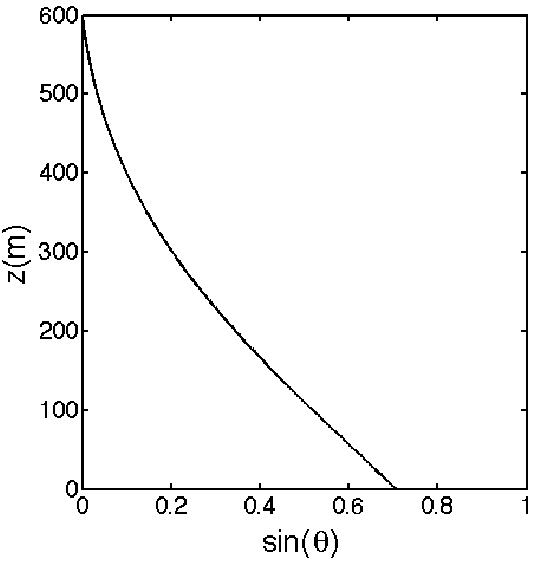
Figure 2. sin θ ( z ) profile (Equation (9)) using Ekman’s assumptions and γ = π Figure 2. sin 𝜃(𝑧) profile (Equation (9)) using Ekman’s assumptions and 𝛾 = (cid:3095)